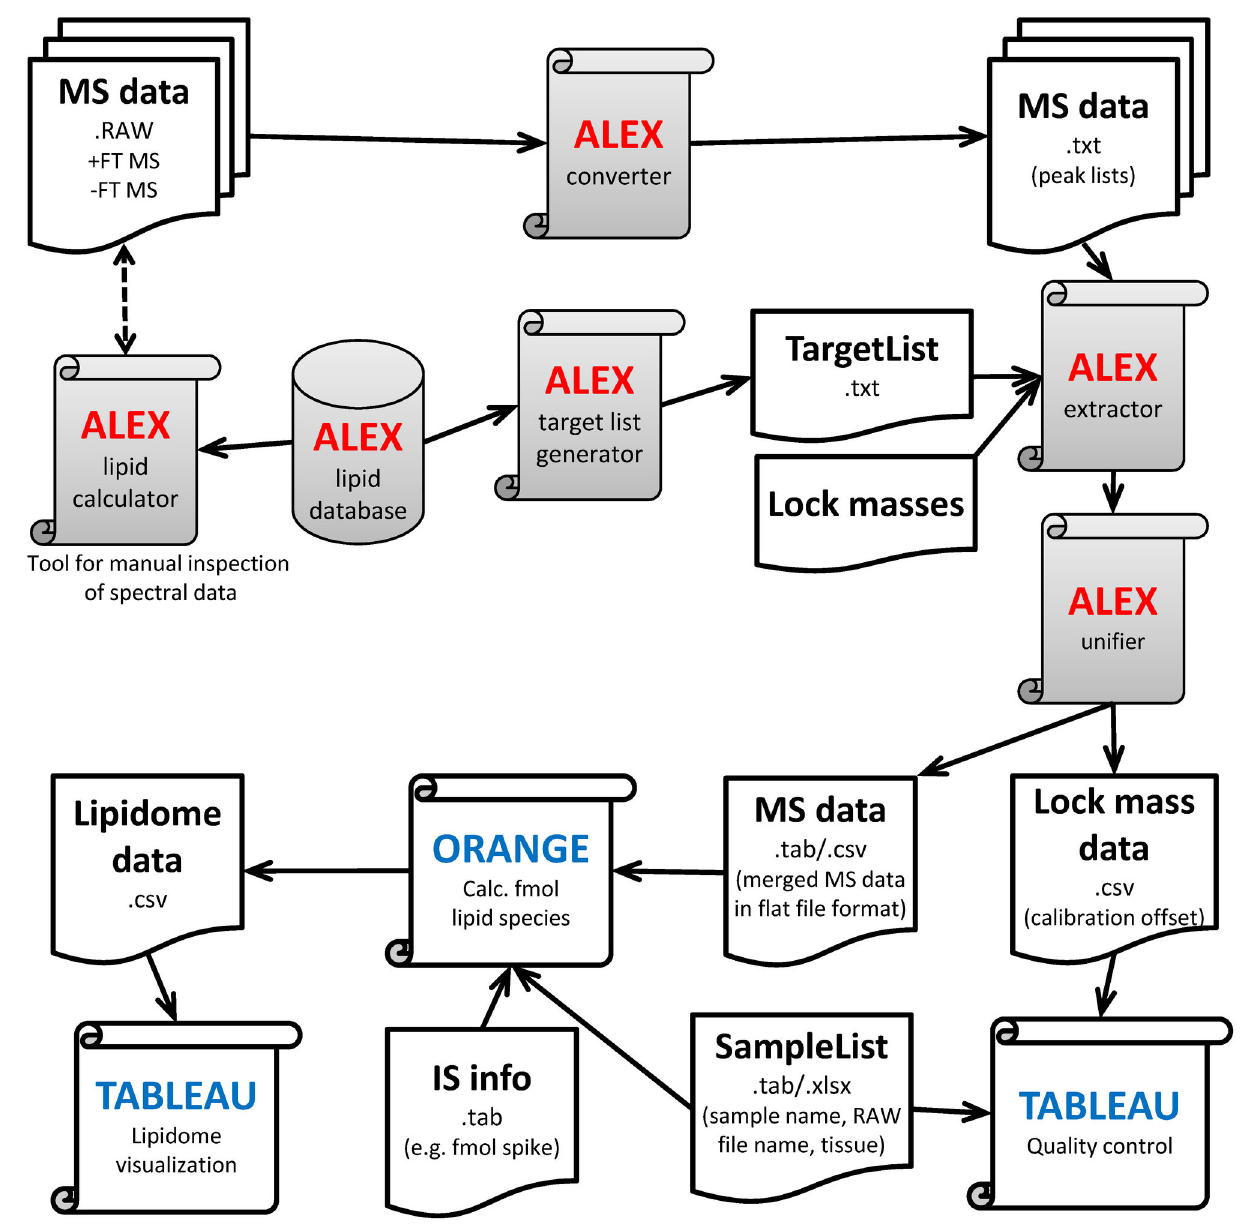
Figure 1. Overview of the ALEX software framework and auxiliary workflow. The ALEX framework comprises six core modules (grey colored boxes). The function of each module is explained in the Results and Discussion section. The output of the ALEX framework includes a data file with identified lipid species, intensities and accessory lipid features across all processed samples and FT MS scan ranges. The ALEX output is organized in database table format that can be accessed and processed by the auxiliary workflow using Orange and Tableau software. The auxiliary workflow is designed to integrate sample information, compute lipid molar abundance, implement quality control procedures and visualize lipidome